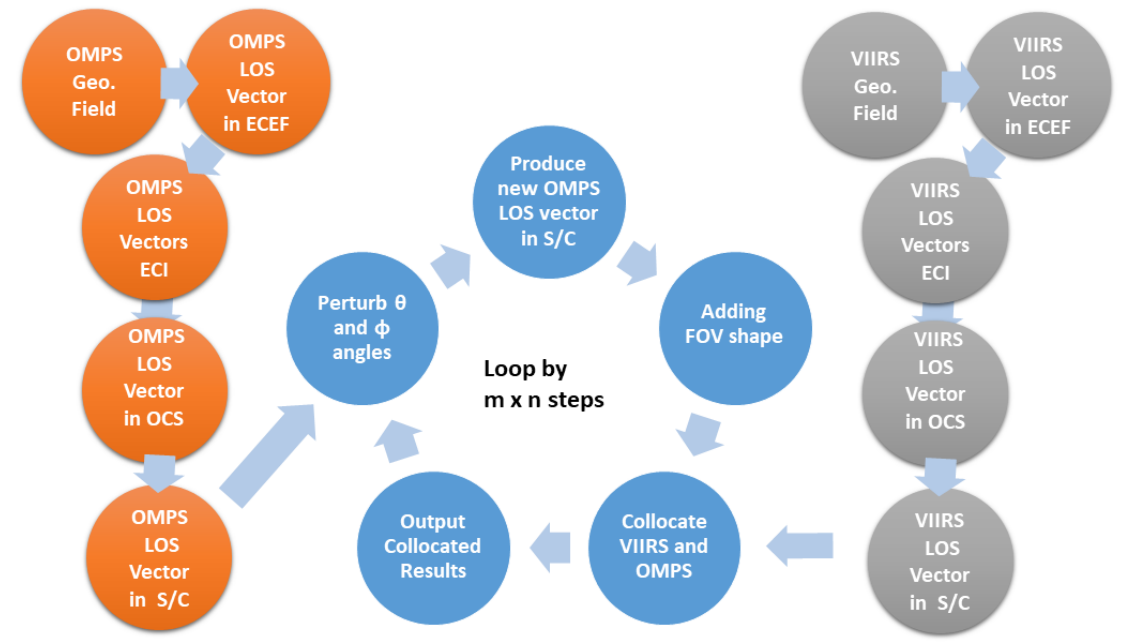
Figure 12. Flowchart describing the method of quantifying OMPS-NM geolocation accuracy using VIIRS M1 band geolocation